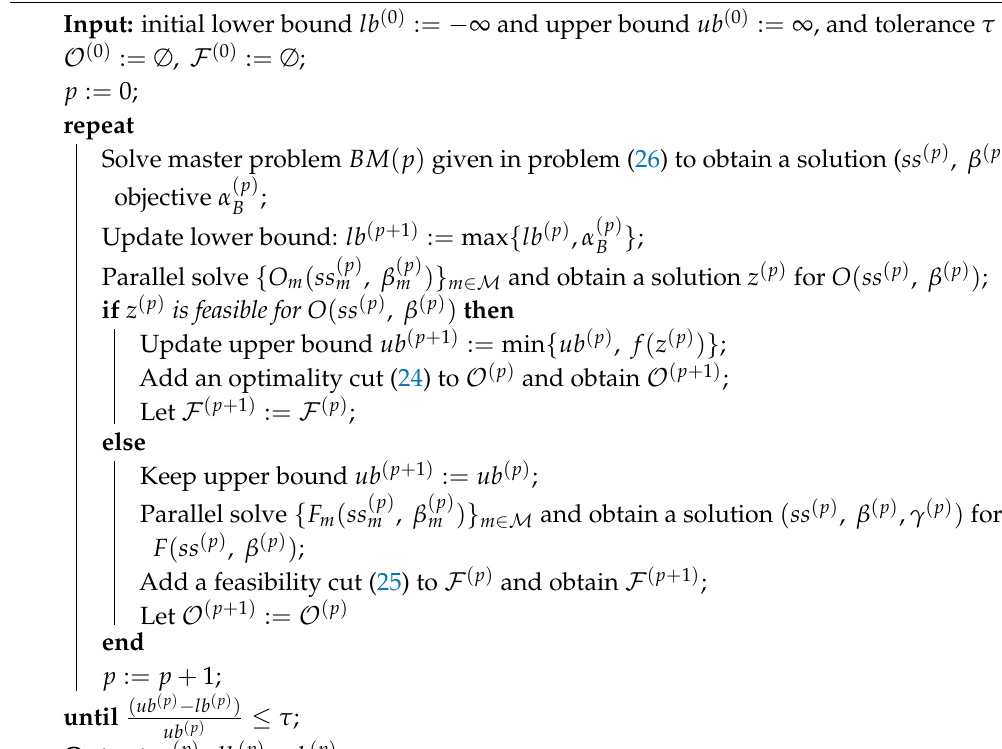
Algorithm 1 formalizes the Benders decomposition. The algorithm does not require a feasible starting point, since it can produce a feasible solution if one exists with the aid of the feasibility cuts. Algorithm 1: Benders